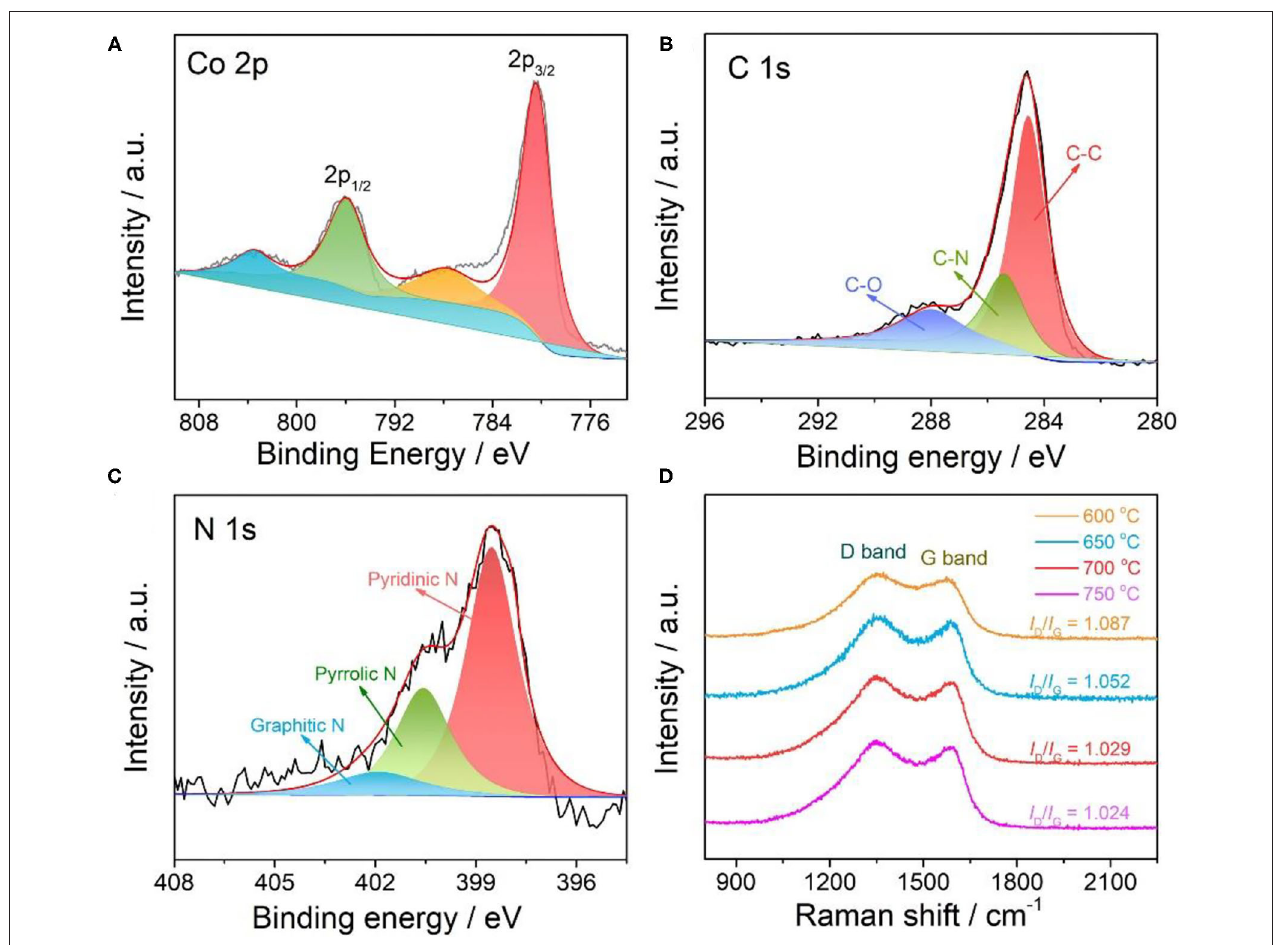
FIGURE 3 | High-resolution XPS spectra of (A) Co 2p region, (B) C 1s region, and (C) N 1s region, respectively; (D) Raman spectrum of